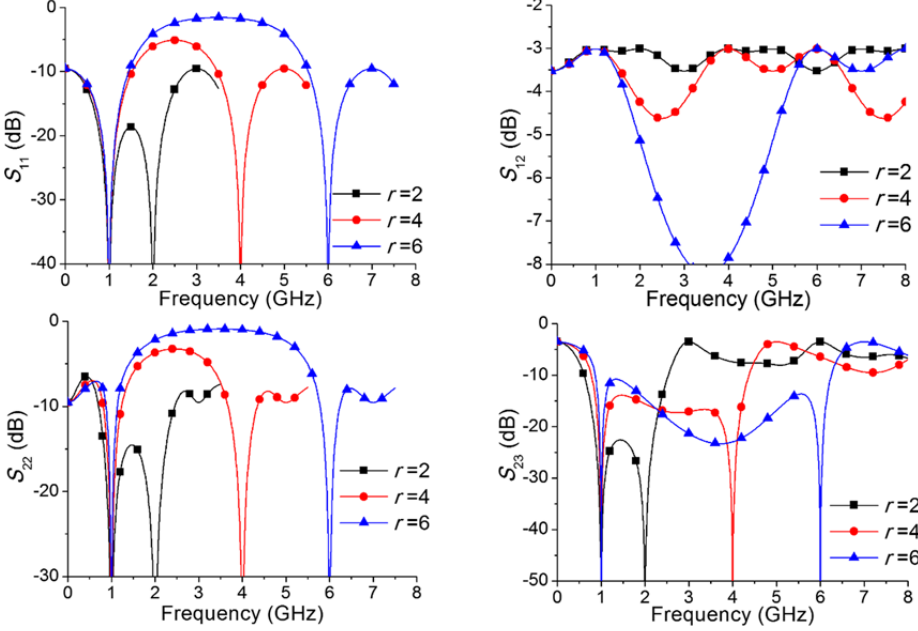
Figure 6. The simulated S-parameters of various designs with di ff erent frequency ratios to show the applicability of the proposed